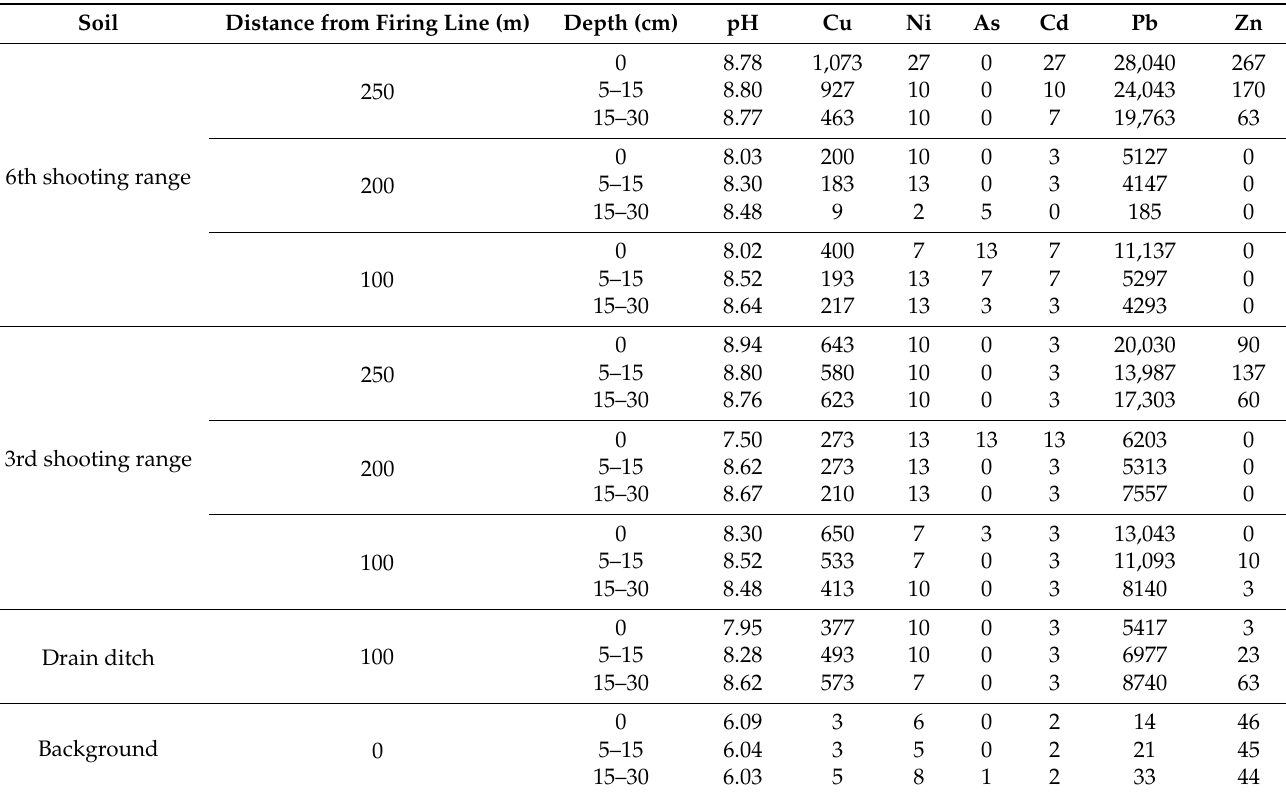
Table 1. The total Cu, Ni, As, Cd, Pb, and Zn concentration (ppm) and pH in soils of shooting ranges. Soil